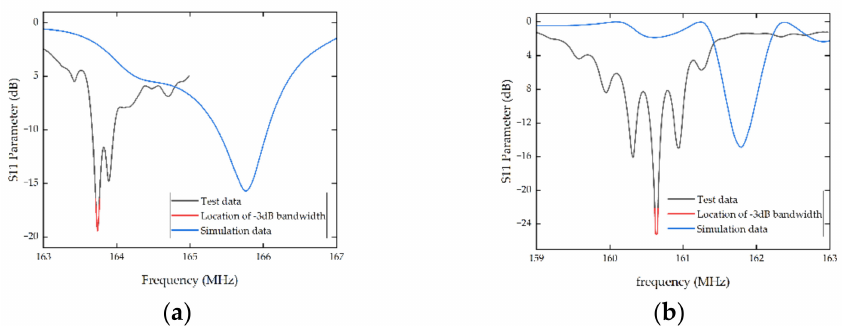
Figure 12. S11 curves of device A and device B at room temperature. ( a ) The comparison results between the simulation data and test data of device A, ( b ) the comparison results between the simulation data and test data of device B.